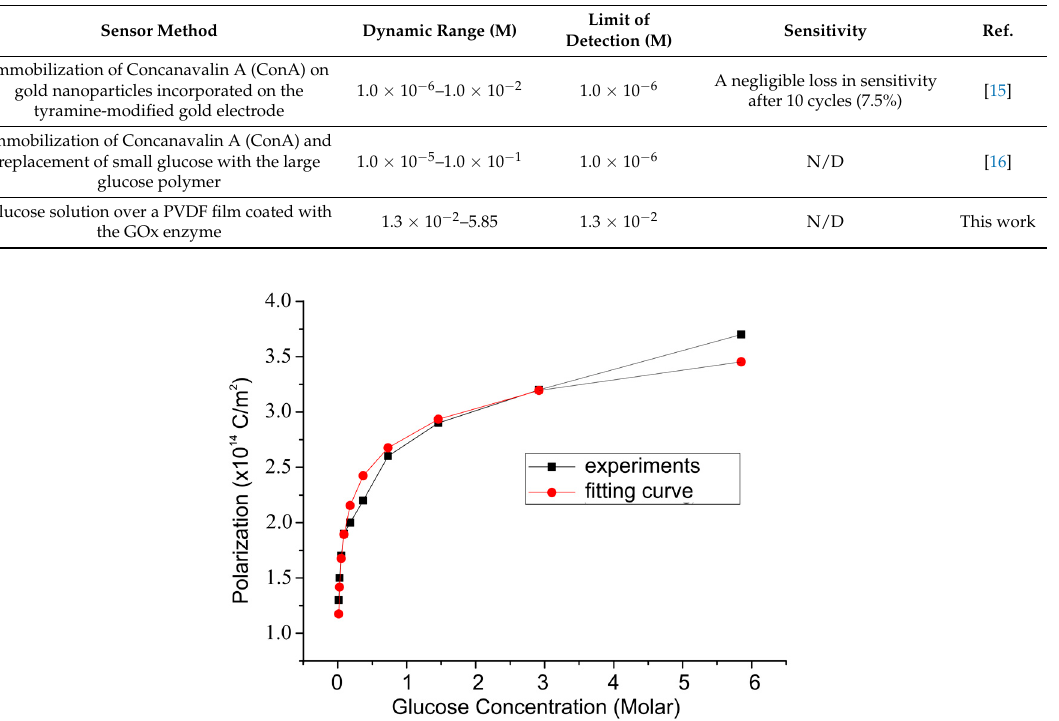
Table 5. Dynamics range, limit of detection, and sensitivity of capacitive biosensors for glucose detection.